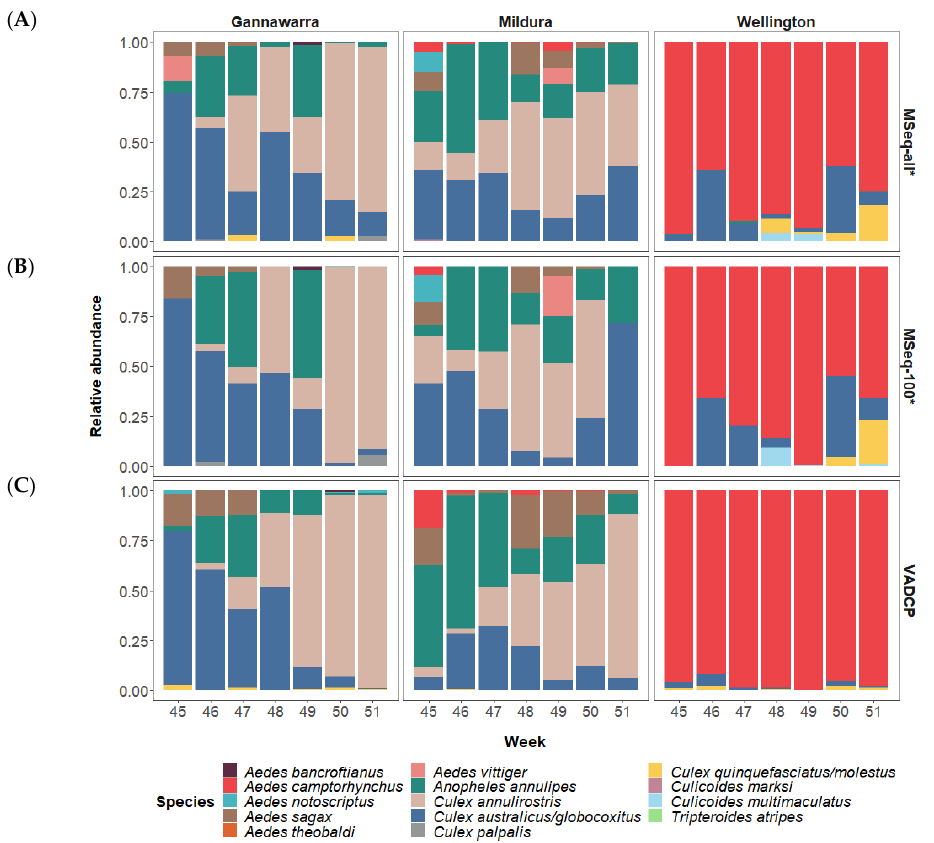
Figure 4. Mosquito and biting midge species identification in traps from Gannawarra, Mildura and Wellington over seven weeks (45–51) in 2016. Relative abundance estimations derived from a COI-based analysis of metatranscriptomic sequencing (MSeq) are shown in ( A ) when using all subsamples and ( B ) when using only the 100-mosquito subsamples. Members of the Culex pipiens species complex that cannot be differentiated by COI have been conglomerated. ( C ) shows species abundance based on morphological identification of mosquitoes subsampled from each trap by the Victorian Arbovirus Disease Control Program (VADCP) during the 2016/17 season. It should be noted that the VADCP does not survey biting midge species. The * indicates that ( A , B ) represent a separate mosquito subsample to ( C